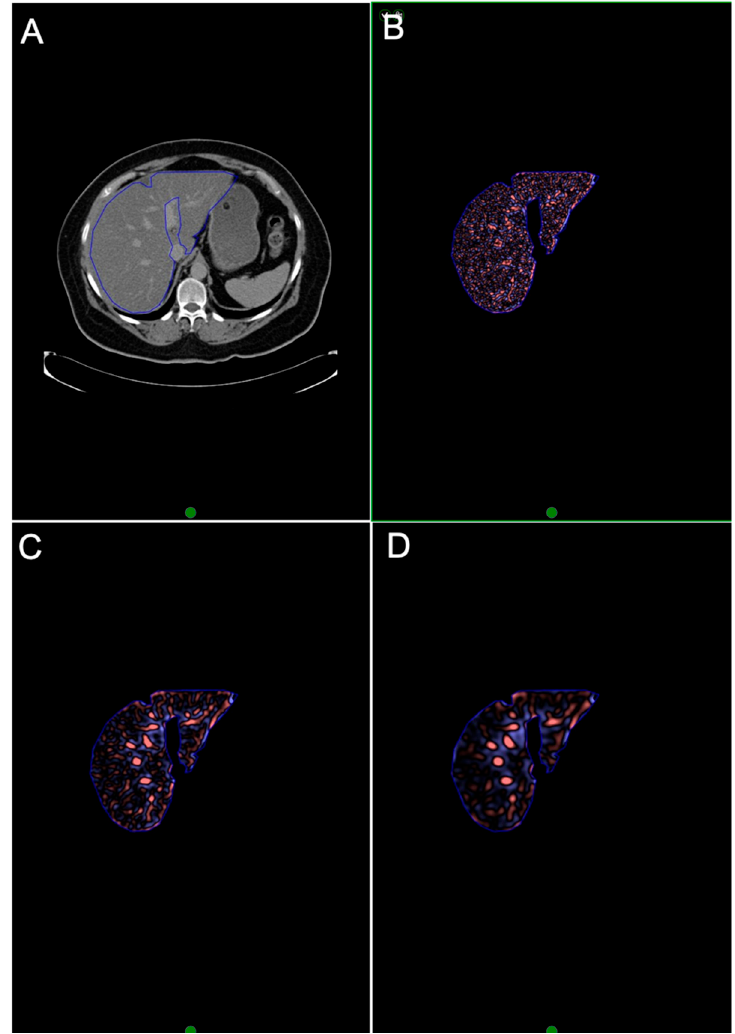
Figure 3. Texture analysis of EQ-CT data in whole liver. ( A ) EQ-CT (post-contrast phase) showing whole liver region of interest. ( B – D ) highlights the initial filtration step, where B reflects fine (features of 2 mm in size) texture map, C reflects medium (4 mm) texture map and D reflects coarse (6 mm) texture map. (EQ-CT: equilibrium contrast-enhanced CT.)